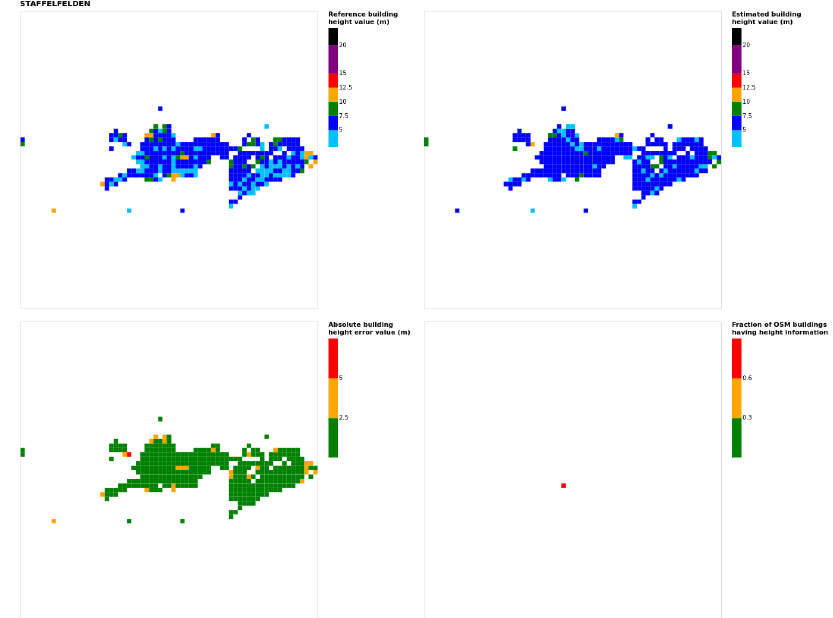
Figure B22. Results for the commune at grid cell (upper left panel) reference building height, (upper right panel) estimated building height, (lower left panel) absolute building height error, and (lower right panel) fraction of OSM buildings that have height information. For all panels except the lower right, only cells that have buildings – with at least 90% of their buildings having no height value in OSM – are